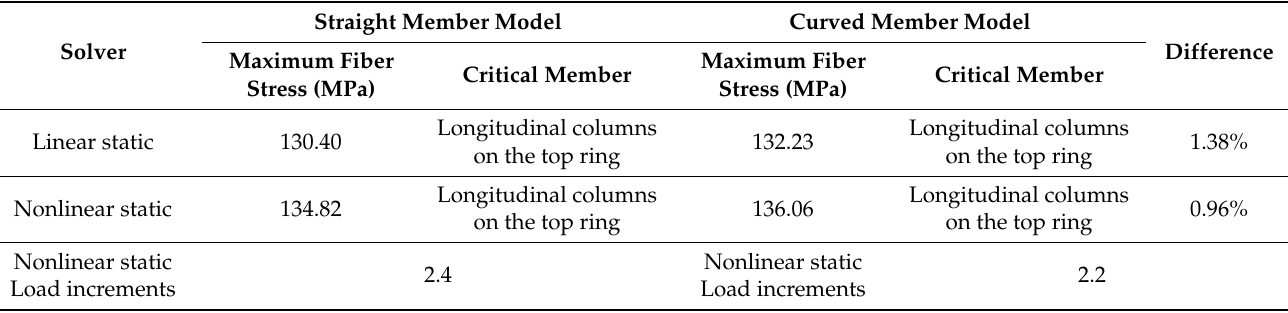
Table 4. Fiber stresses under 1.2G + 1.5Q.